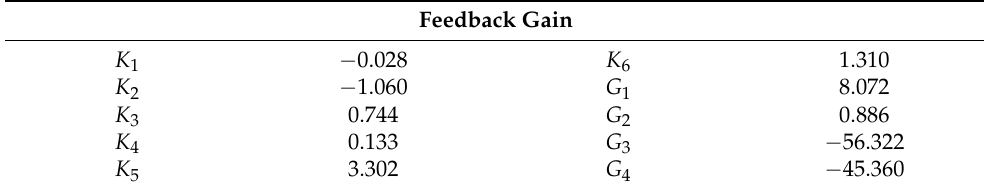
Table 3. Parameters of LQR for Q = diag [5,5,2,100,1000], R = diag [1,1].